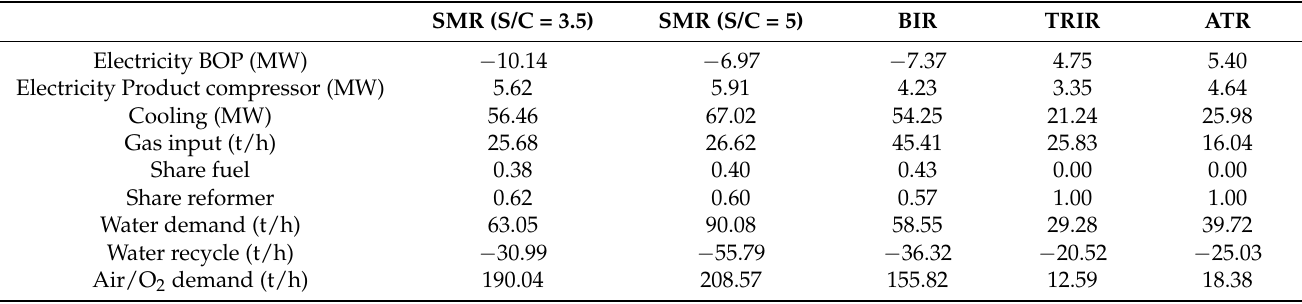
Table 9. Calculated utility and materials